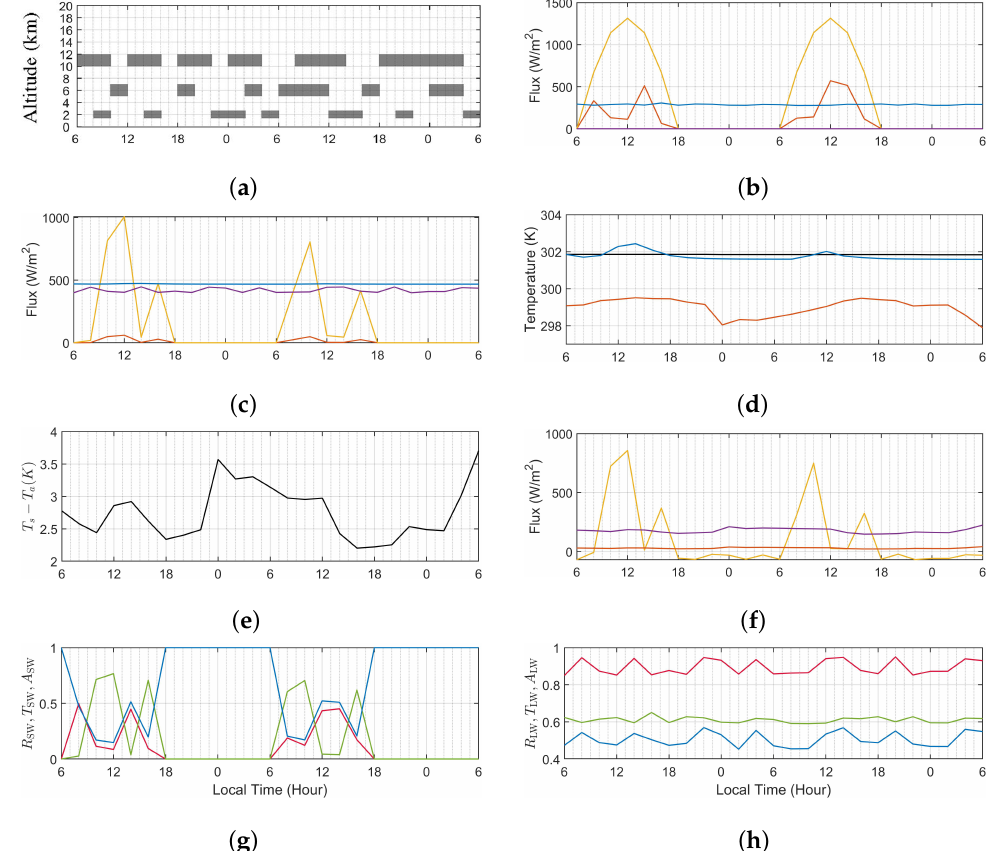
Figure 9. Simulation data over 48 h (d1h6-d3h6) in hiatus period, ( a ) cloud pattern, ( b ) flux